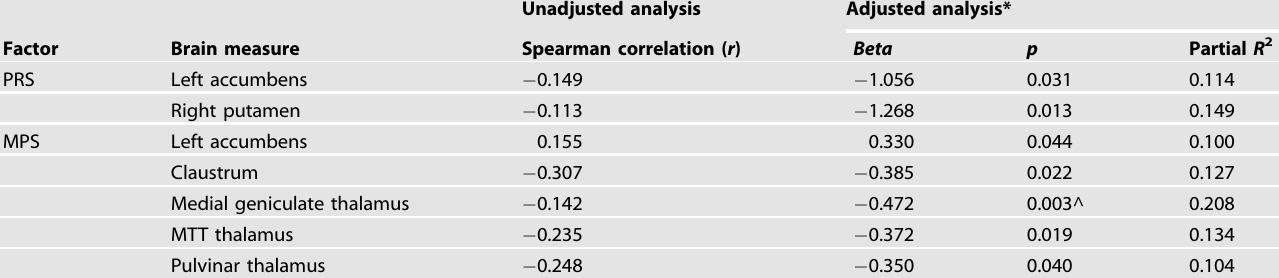
Table 2. Signi fi cant relationship between genetic or environmental factors and brain structure measures (nominal p <